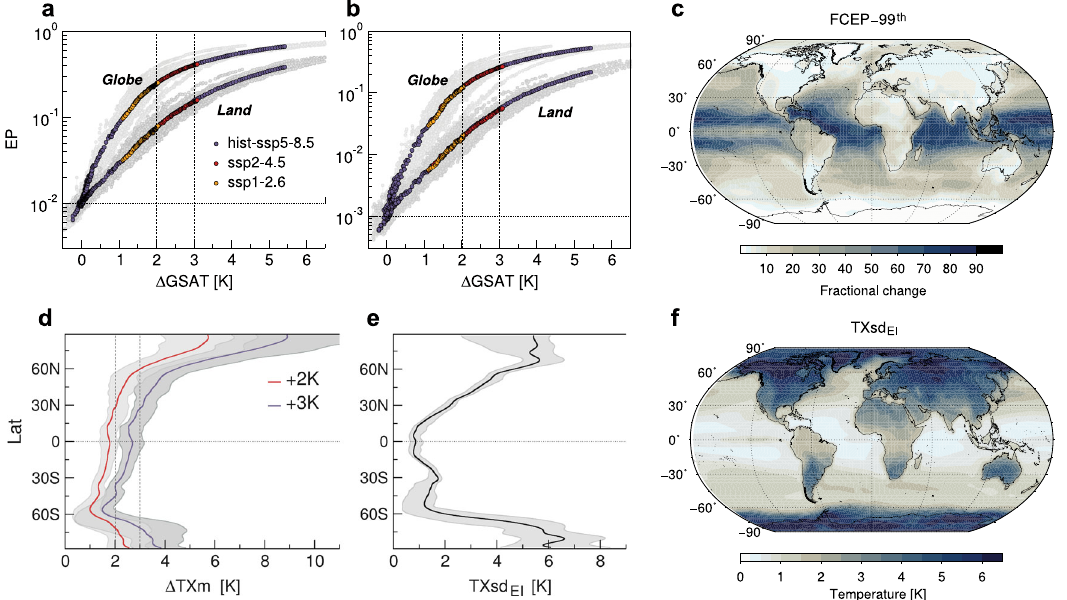
SSP5-8.5), expressed in fractional terms relative to the early industrial. Namely, FCEP = Δ EP / EP EI with EP EI =0.01. d Zonalchangesintheannualaverages TXm at+2K and +3K warming. e , f Zonal and grid-point standarddeviations TXsd , respectively, as simulated in the multimodel mean over the early industrial era. Gray-shaded bands ( d , e ) denote the intermodel